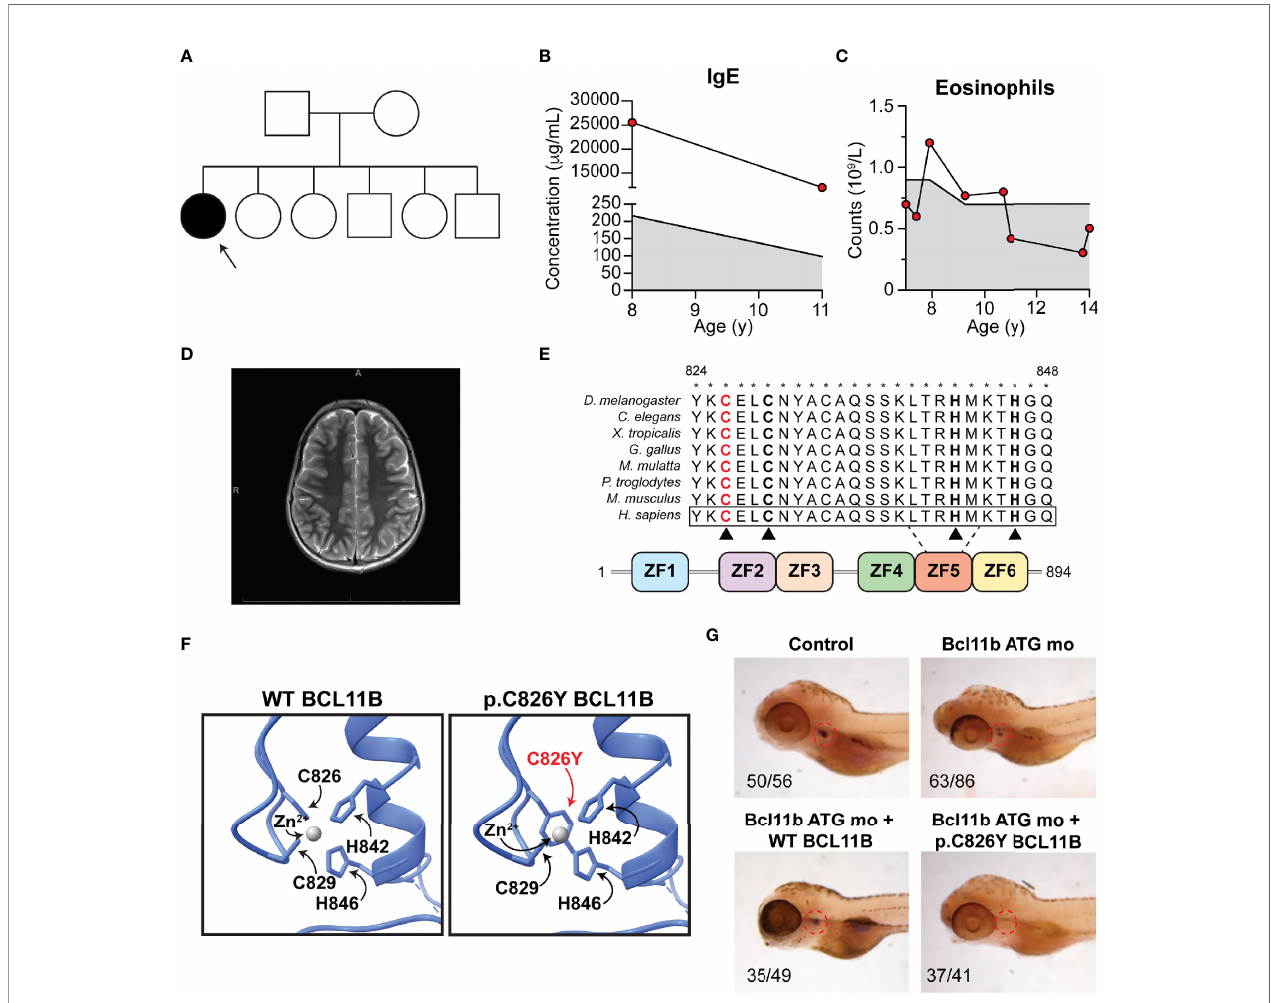
FIGURE 1 | Patient phenotype and functional validation of a novel BCL11B variant. (A) Family pedigree. Arrow, proband. (B) Patient IgE at ages 8 and 11. (C) Patient eosinophil counts from ages 7 to 14. (B, C) Shaded region, reference range. (D) Patient brain magnetic resonance imaging. (E) Schematic of BCL11B protein. Red, substitution location. Asterisks, conservation. Black triangles, zinc coordinating residues. ZF, zinc fi nger. (F) Homology-based modeling of affected region. (G) Rescue of T-cell development visualized by lck probe post- bcl11ba knockdown with Bcl11b ATG mo and heat-inducible reexpression of WT (bottom left) or p.Cys826Tyr BCL11B (bottom right). Indicated are the number of individuals with observed